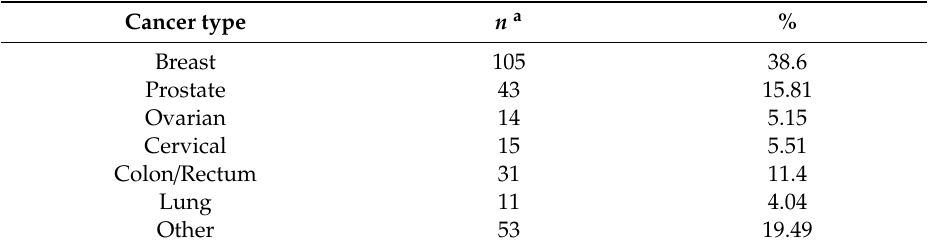
Table 2. Cancer Diagnosis of Surveyed